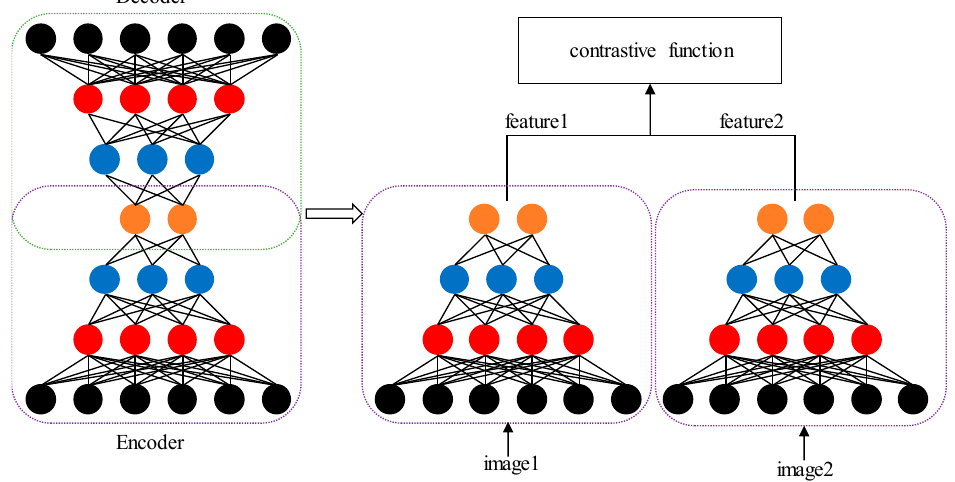
Figure 6. The architecture of AE with five hidden layers at the left side and the architecture of the Siamese framework based on AE model at the right side.